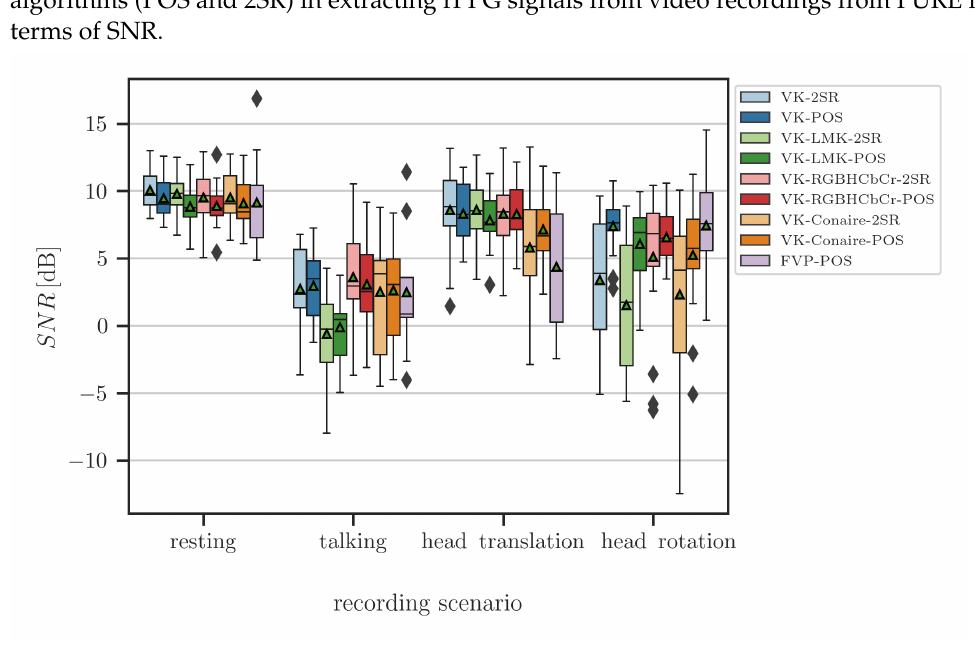
Figure 2. Performance of the studied approaches with and without ROI localization step in com- bination with two rPPG algorithms (POS and 2SR) in terms of SNR for PURE. VK: Viola-Jones combined with ROI width reduction and Kanade-Lucas-Tomasi tracker; VK-Conaire: Viola-Jones combined with skin detector based on the maximization of mutual information and Kanade-Lucas- Tomasi tracker; VK-LMK: Viola-Jones combined with landmarks detection and Kanade-Lucas-Tomasi tracker; VK-RGBHCbCr: Viola-Jones combined with RGB-H-CbCr skin-color segmentation and Kanade-Lucas-Tomasi tracker; FVP: Full Video Pulse Extraction rPPG algorithm. Black horizontal lines denote median SNR values, upper and bottom sides of the boxes the 25th and 75th percentiles, and whiskers extend to the values not considered as outliers, which are marked with black diamonds; green triangles denote mean SNR